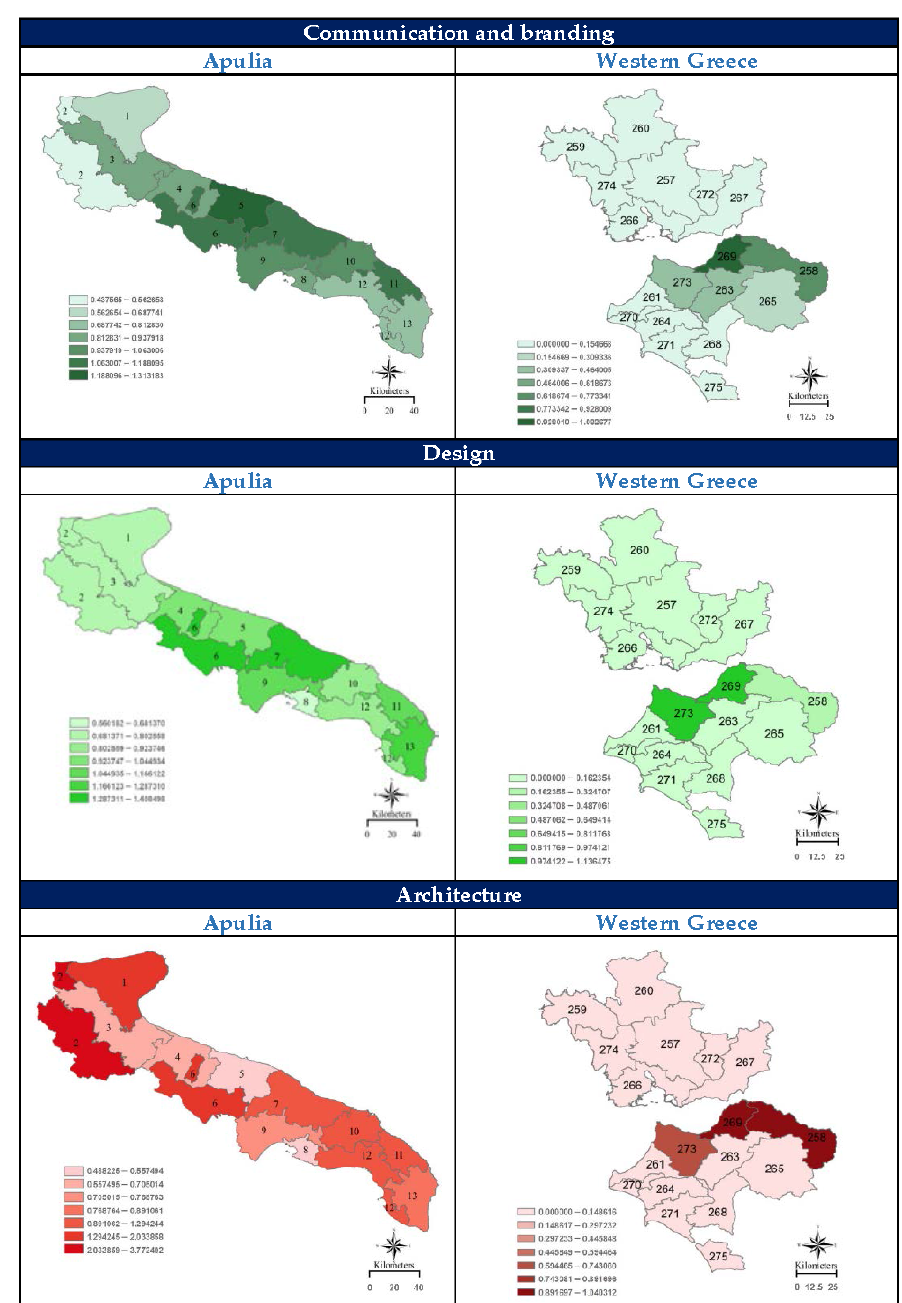
Figure 2. Regional specialization in the Creative Industries sector. Apulia: 1—Gargano;